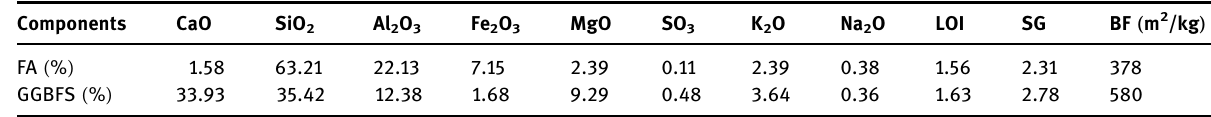
Table 1: The properties of FA and GGBFS Components